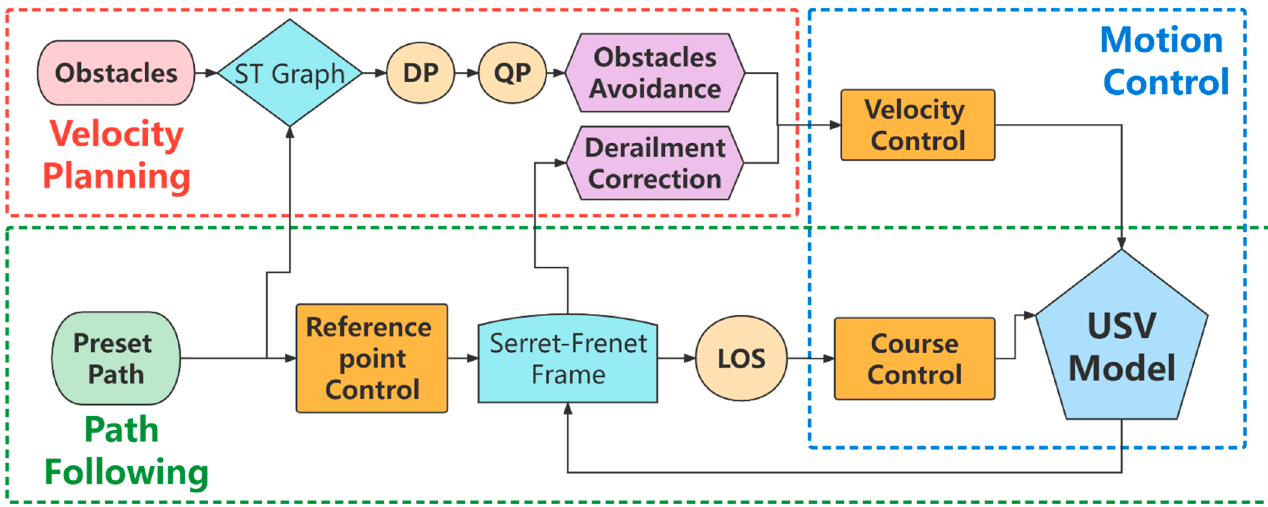
Figure 1. Illustration for research framework of this paper.